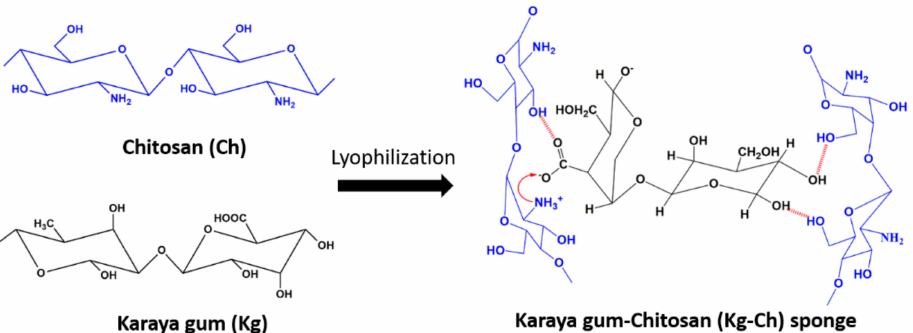
Figure 1. Schematic representation of the formation of Kg-Ch sponge from Karaya gum and